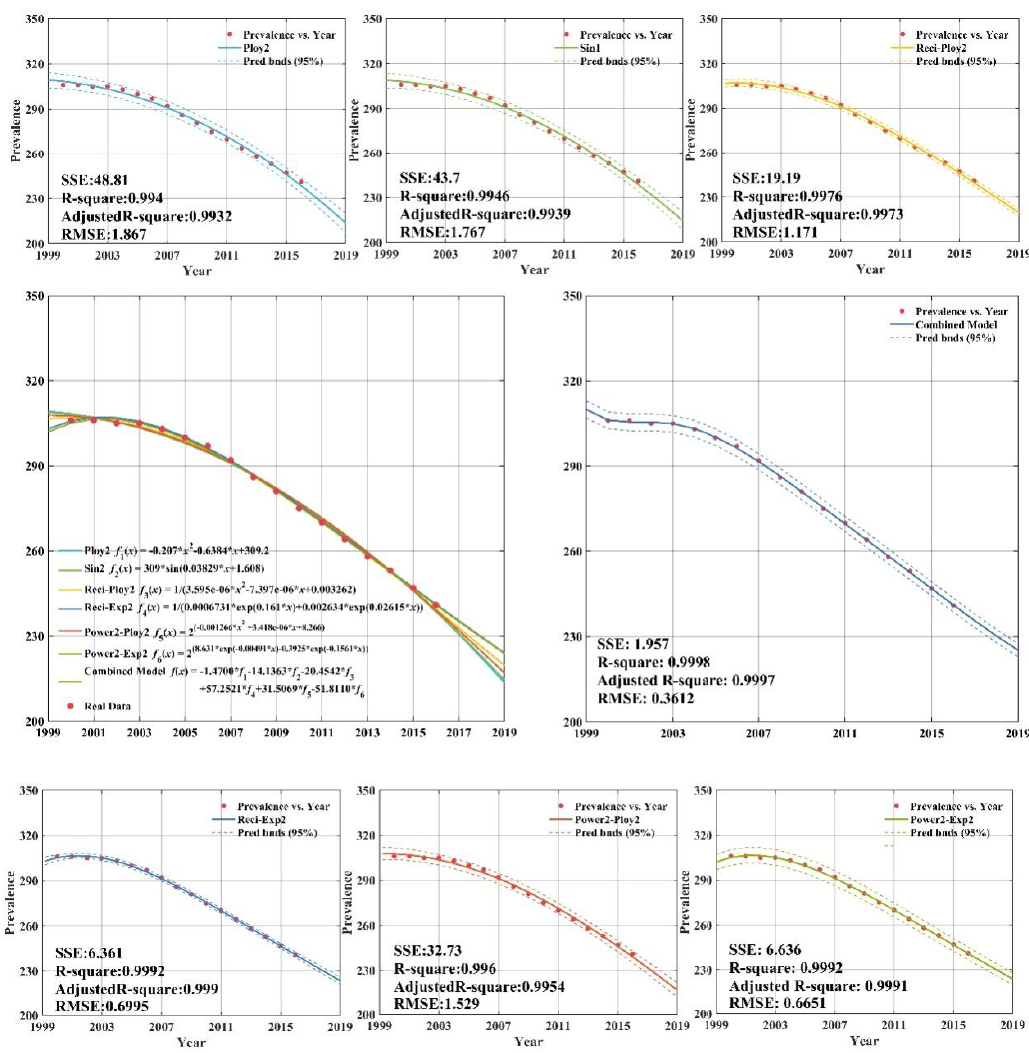
Figure A3. Fitting and forecasting curves for the lower-middle income group.